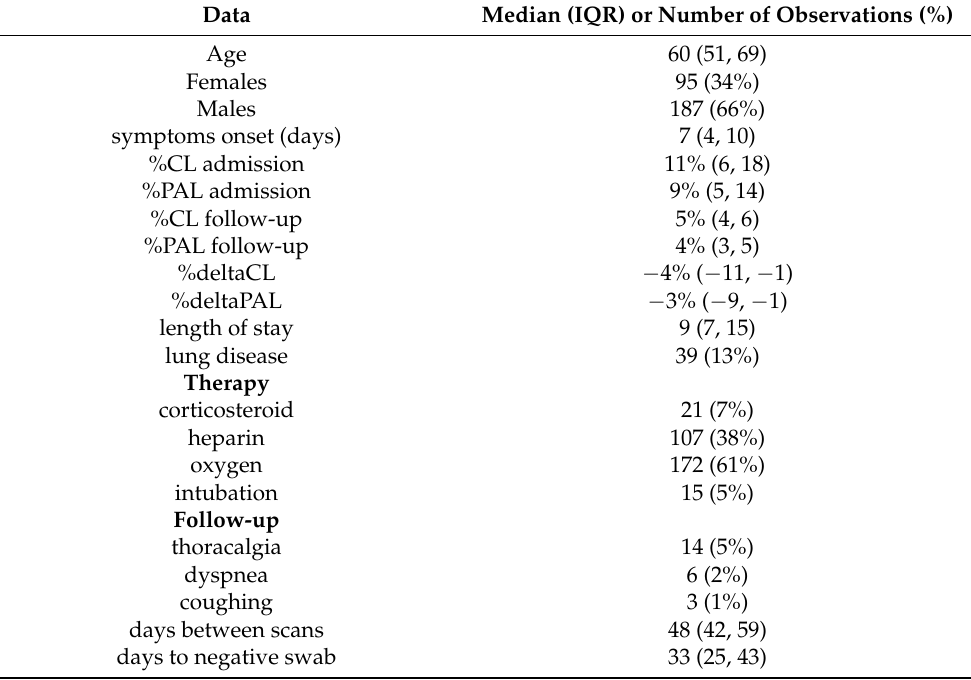
Table 1. Patients’ demographics and clinical